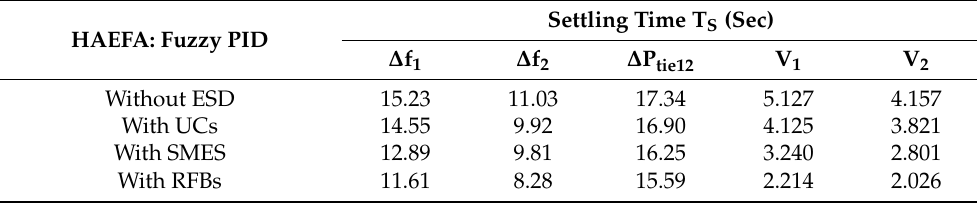
Figure 10. Responses for case-3: ( a ). ∆ f 1 , ( b ). ∆ Ptie 12 , ( c ). ∆ f 2 , ( d ). V 1 and ( e ). V 2.